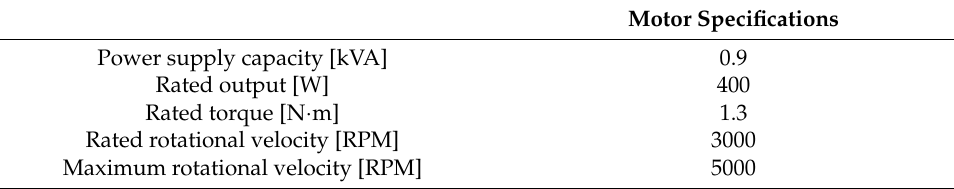
Table 2. Specifications of the motor.